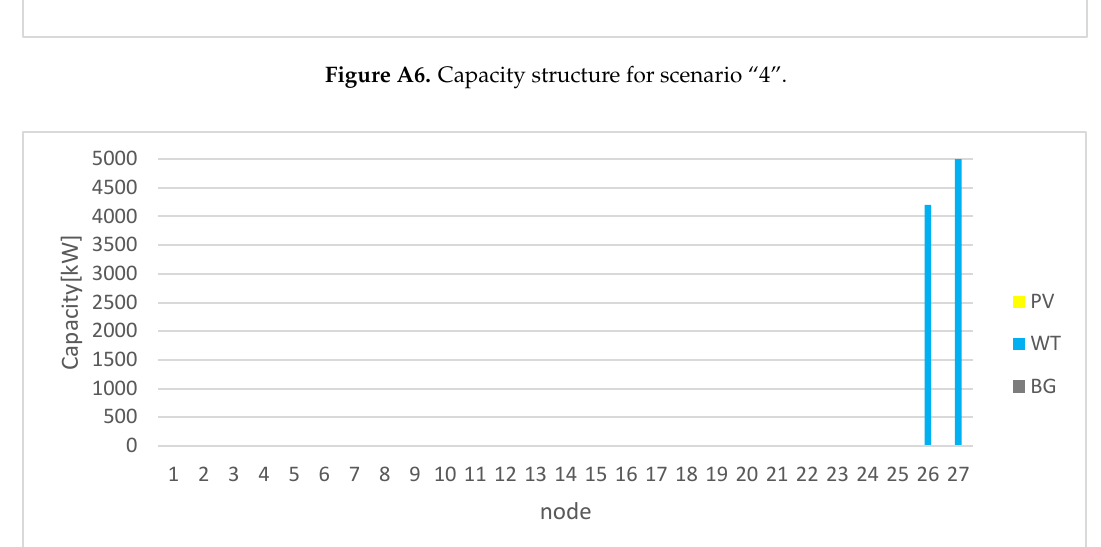
Figure A7. Capacity structure for scenario “5”.